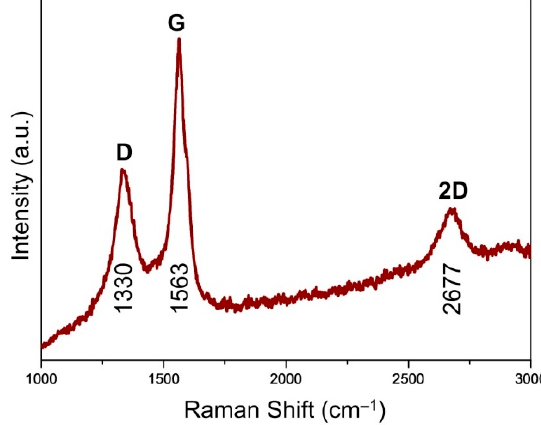
Figure 4. Porosimetry on graphene deposited on MgO. ( a ) N 2 adsorption-desorption isotherms as a function of equilibrium relative pressure and ( b ) pore size distribution of graphene after etching the host MgO templates.